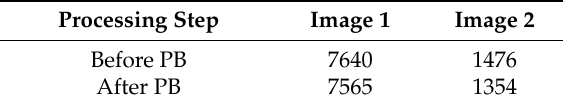
Table 4. Performance of Step 4: Prune blobs.